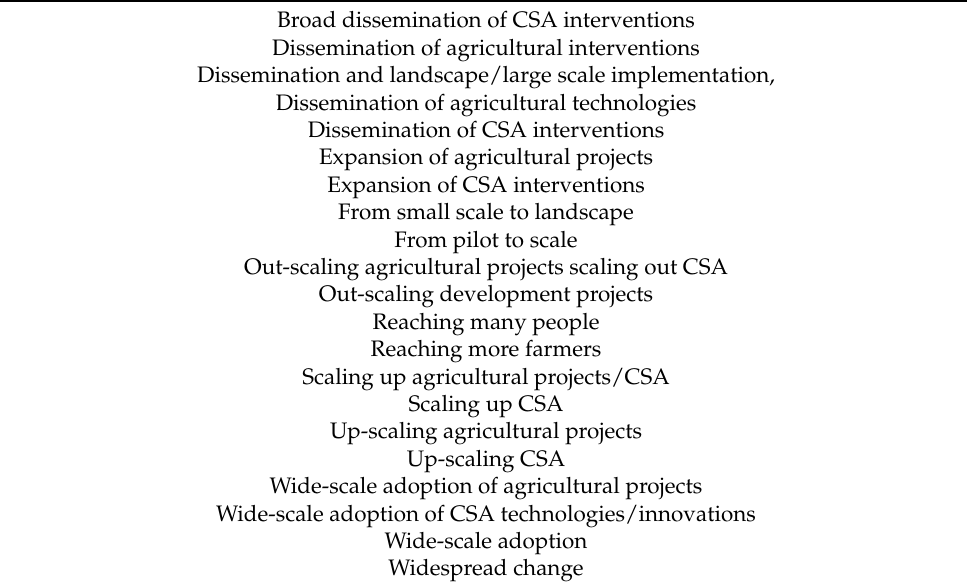
Table 1. Terminologies/search strings